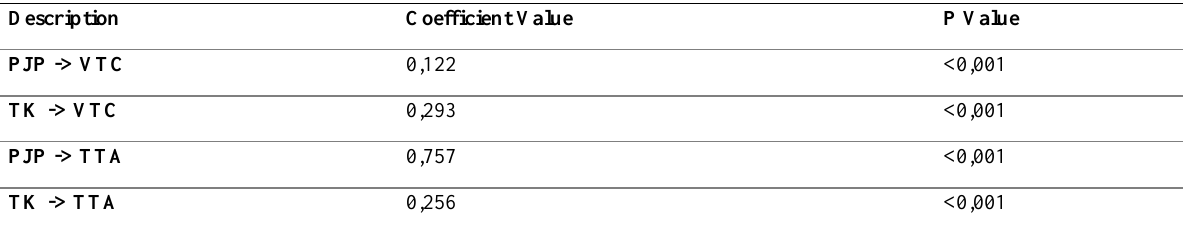
Table 6: Phase 1 Test Result